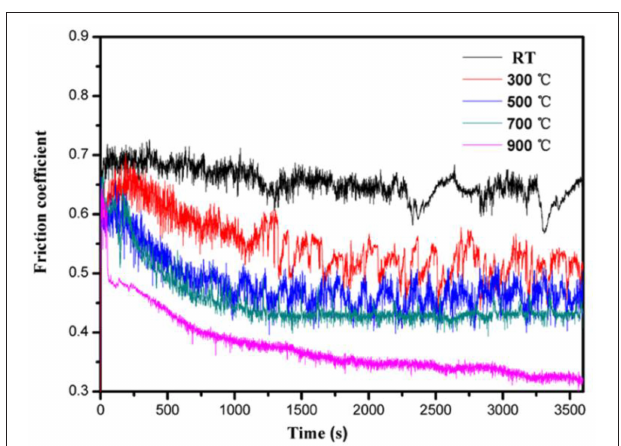
FIGURE 8 | Friction coefficient of coating at different friction test temperatures.